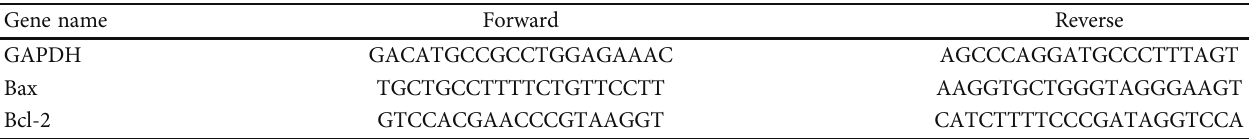
Table 2: Primer sequences of mRNA